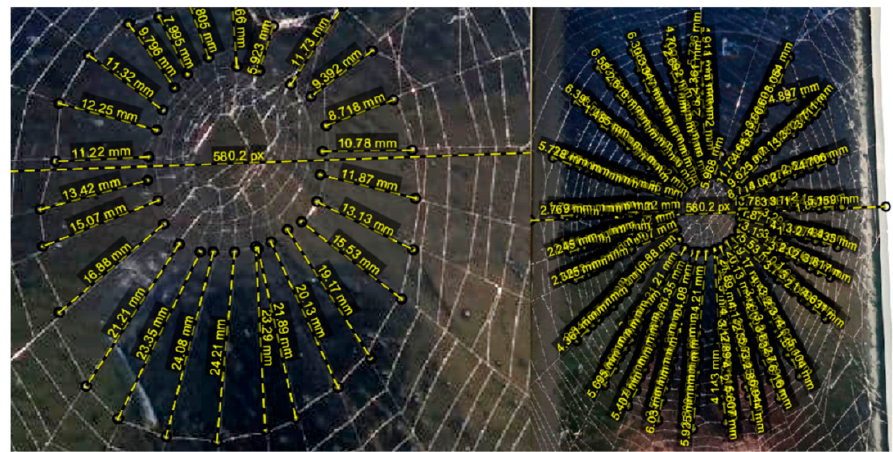
Figure 8. First spiral statistical geometric data and point of location indication.